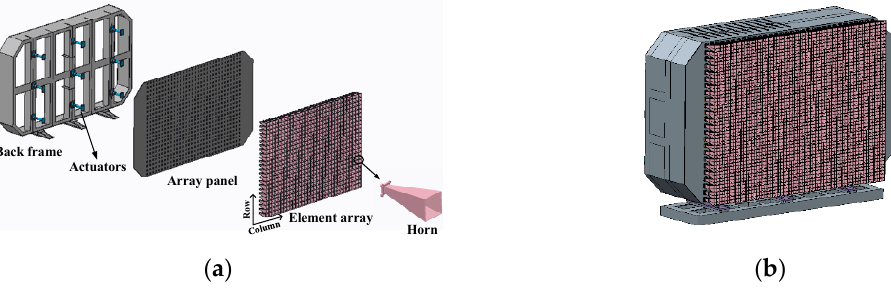
Figure 3. ( a ) Composition diagram of X-band active phased array antennas (APAA); ( b ) active phased array antenna model.